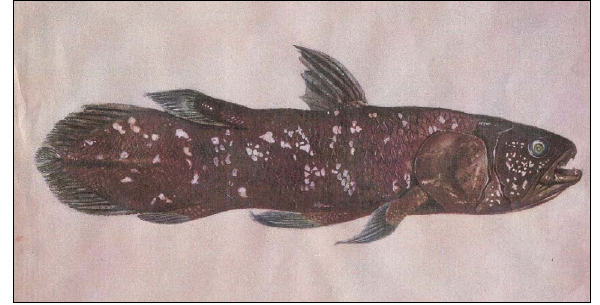
Figure 2: Coelacanth CCC 251 caught in March 2001 at Fiherenemasay and now in the collection of the IHSM Museum, Toliara (photo provided by D. Stanwell-Smith).